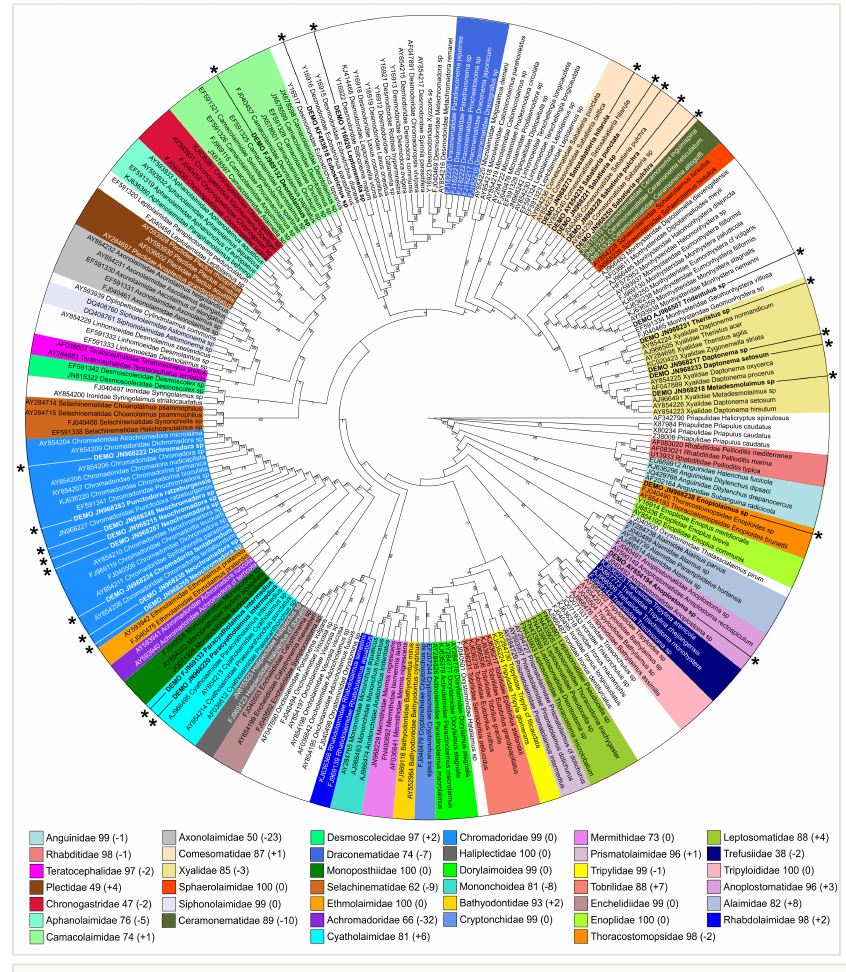
"Best case" scenario – Maximum likelihood tree inferred using PRANK-based alignment of the "long" dataset and 25 additional sequences (marked by asterisks). Numbers after family names in the legend indicate current bootstrap support for each clade and di ff erence (in parenthesis) comparing to the original analysis (PRANK-based alignment, Maximum likelihood phylogeny inference, "long" dataset) from the section 3.2 of the